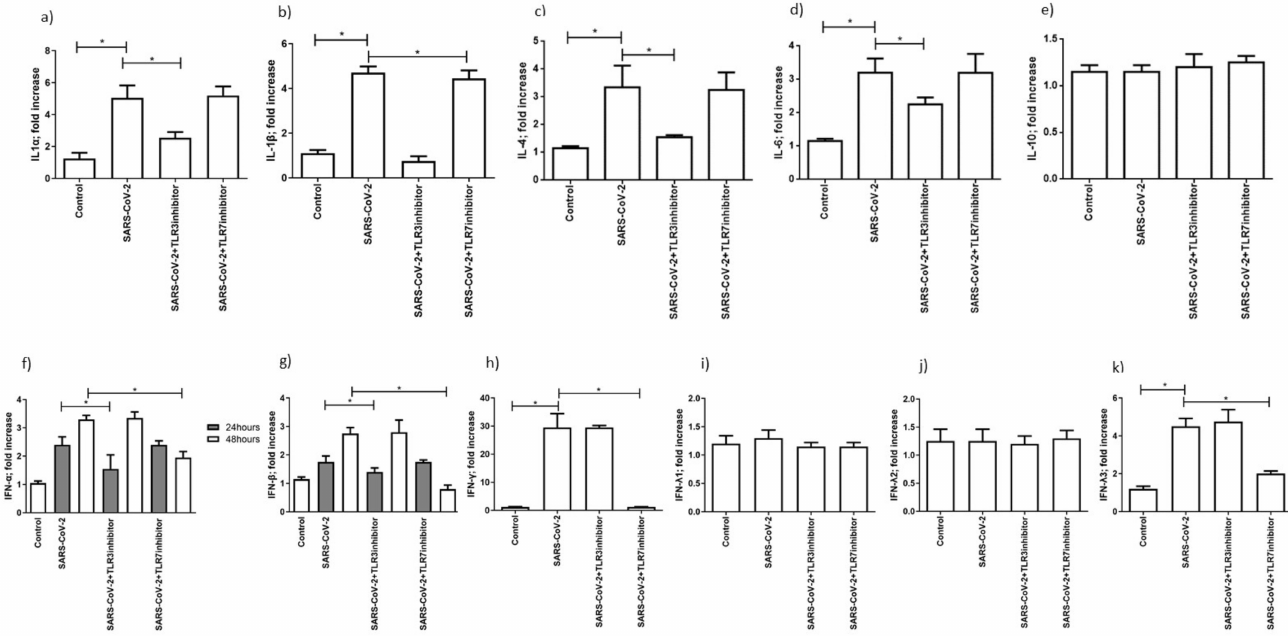
Figure 3. Levels of expression of cytokines ( a ) IL-1 α , ( b ) IL-1 β , ( c ) IL-4, ( d ) IL-6 and ( e ) IL-10 are reported after 48 h post-infection. The levels after 24 h post-infection were under the detection limit of the assays. Levels of ( f ) IFN- α , ( g ) IFN- β are reported 24 and 48 h post-infection. Data correspond to the mean +/ − standard deviation. * p value < 0.05, calculated with Student’s t -test. Levels of ( h ) IFN- γ , ( i ) IFN- λ 1, ( j ) IFN- λ 2, ( k ) IFN- λ 3 are reported 48 h post-infection. The levels after 24 h post-infection were under the detection limit of the assays. Data correspond to the mean +/ − standard deviation. * p value < 0.05, calculated with Student’s t